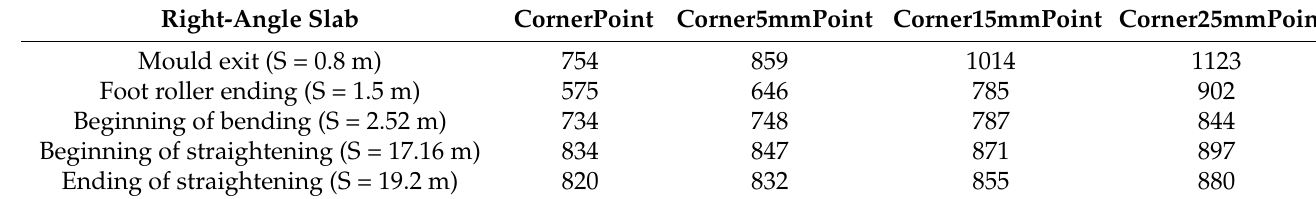
region. The temperature is 787 ◦ C at the beginning of bending (S = 2.52 m), the film-like ferrite phase still exists, and cracks are easy to generate during the bending process. The temperature at the Corner25mmPoint is 844 ◦ C, which is in the austenite region at the beginning of bending. Table 4. Temperature of right-angle slab under intensive cooling (°C). Table 4. Temperature of right-angle slab under intensive cooling ( ◦